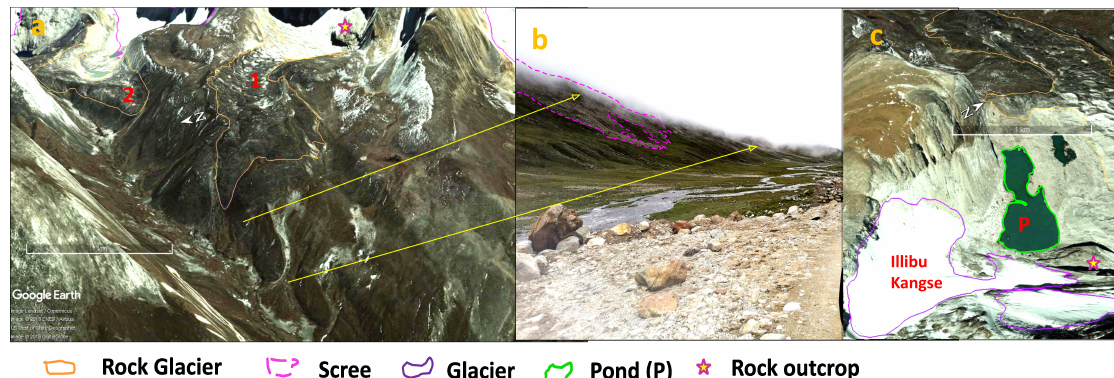
Figure 10. Field photograph of the upper reaches of the debris-covered glacier CK lateral moraines (red polygons) enclosing the glacier; the black dashed separation line marking the accumulation area (AC), in the upper part and debris-covered ablation area (AB), in the lower part; the avalanche cones (magenta colored polygons).